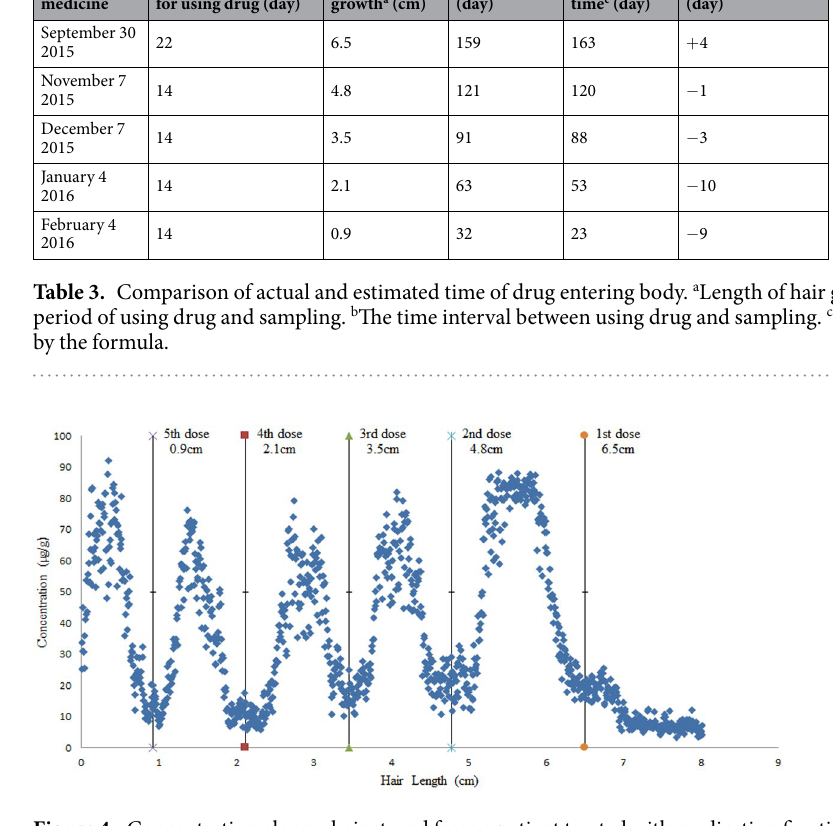
Figure 4. Concentration along a hair strand from a patient treated with medication five times, 10 mg As2O3 per day lasting 14 days for each course of treatment (except for the first